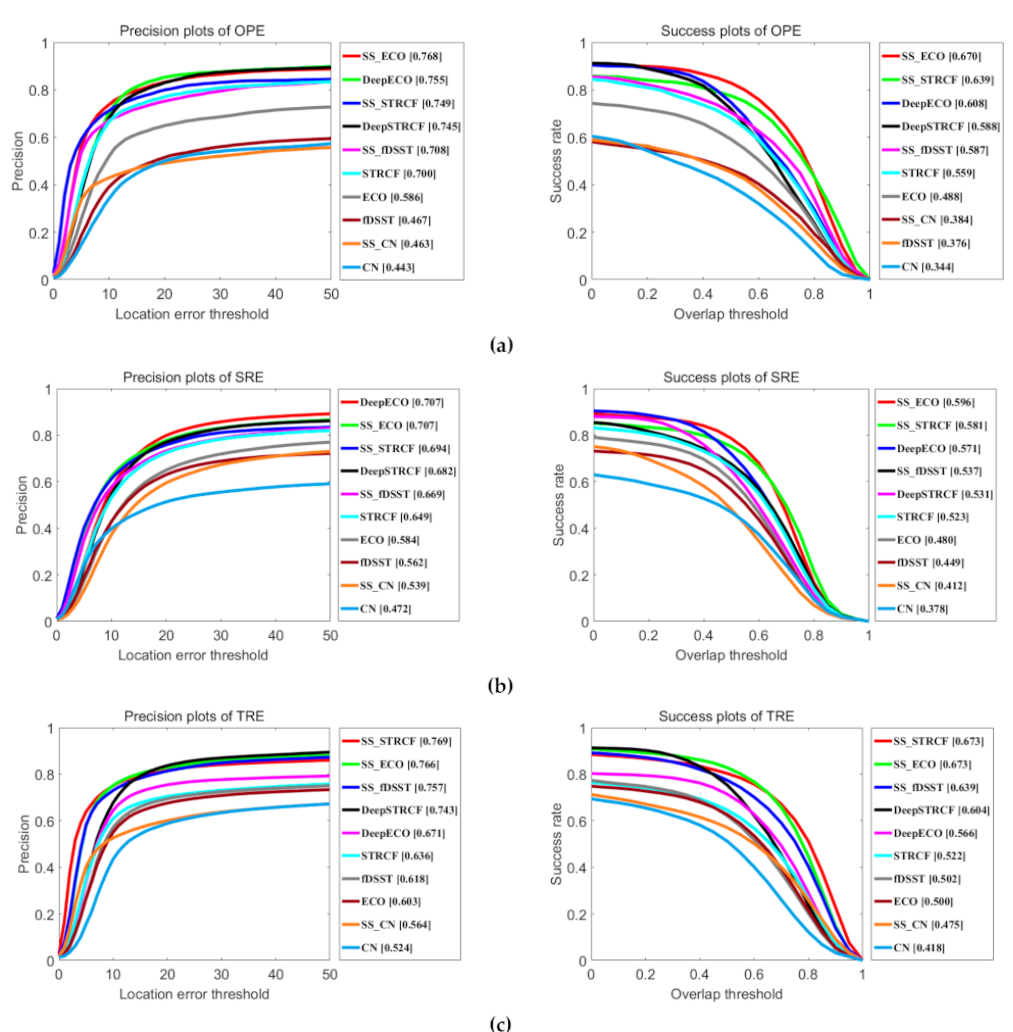
Figure 13. Comparison results for all SSCF trackers and their baseline trackers using three initialization strategies: one-pass evaluation (OPE), temporal robustness evaluation (TRE) and spatial robustness evaluation (SRE). ( a ) Precision plot and the success plot on OPE. ( b ) Precision plot and the success plot on SRE. ( c ) Precision plot and the success plot on TRE. The legend of precision plots and success plots report the precision scores at a threshold of 20 pixels and area-under-the-curve (AUC) scores,